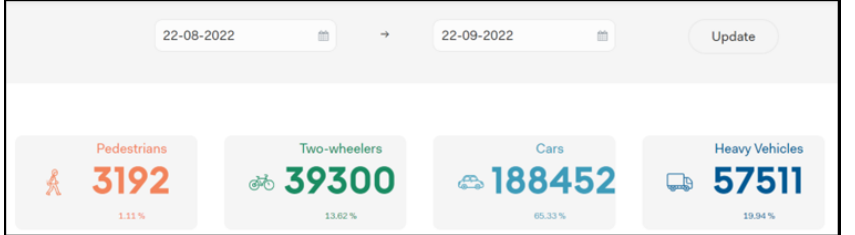
Figure 7. Total number of vehicles per type recorded by the sensor near Sensor 4 for a one month period.